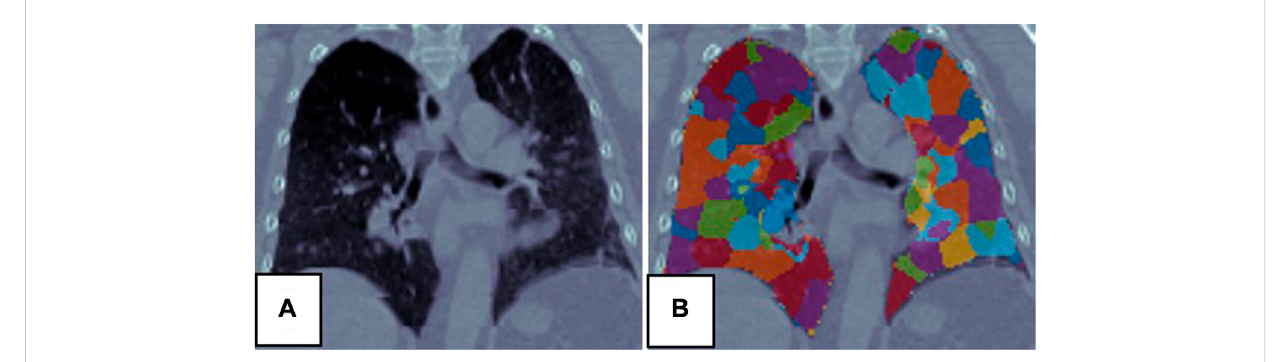
FIGURE 3 Super-voxel segmentation in the lungs of a patient. (A) Is the CT, (B) is the result of the super-voxel segmentation in the lung region.